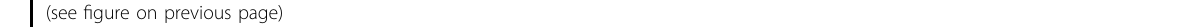
Fig. 4 LSD1 directly interacts with ACE2. a Representative image of uninfected or SARS-CoV-2-infected Caco-2 cells using the Andor WD Revolution Inverted Spinning Disk microscopy system. Cells were permeabilized (intracellular) for immunostaining for ACE2, LSD1, and SARS-CoV-2 N (nucleocapsid). DAPI (blue) was used to visualize nuclei. Scale bar, 12 μ m (inset). The ratio of nuclear to cytoplasmic staining (Fn/c) was also calculated for LSD1 and ACE2: >1 indicates nuclear bias, whereas <1 indicates cytoplasmic bias. The PCC was calculated to assess colocalization in Caco-2 cells with/without infection in the cytoplasmic or nuclear compartments ( n = 20 cells analyzed). Data are mean ± SEM. Mann – Whitney test: ∗∗∗ P < 0.001, ∗∗∗∗ P < 0.0001 denote signi fi cant differences. b Representative image of uninfected or SARS-CoV-2-infected Caco-2 cells using the Andor WD Revolution Inverted Spinning Disk microscopy system. Cells were permeabilized (intracellular) for immunostaining for ACE2, RNA Pol-II, and SARS- CoV-2 N (nucleocapsid). DAPI (blue) was used to visualize nuclei. Scale bar, 12 μ m (inset). Dot plot quanti fi cation of the fl uorescence intensity of ACE2 and RNA Pol-II in uninfected or SARS-CoV-2-infected Caco-2 cells. >50 cells were analyzed for each group. The PCC was calculated for colocalization ( n = 20 cells were analyzed). Mann – Whitney test: ∗ P < 0.05, ∗∗∗∗ P < 0.0001 denote signi fi cant differences. c Representative conservation of the ACE2 c- terminal sequence across multiple species. An NLS (red box) is identi fi ed with three lysines highly likely to be subject to acetylation/demethylation (red). This region may be involved in protein stabilization as there is also a nearby lysine (in orange) highly likely to be ubiquitinated for proteasomal degradation. d ACE2me2 peptide substrate demethylation by LSD1. LSD1 activity was measured by demethylation assay with ACE2me2 peptide of PEP1, PEP2, PEP3, or PEP4. Fluorescent was measured at 40 s intervals on a Synergy H4 multi-mode plate reader. The background rate of ACE2me2 peptide was subtracted in corresponding samples. Statistical signi fi cance was calculated using one-way ANOVA, ∗∗∗∗ P < 0.0001 denote signi fi cant differences. e The C-terminal, cytoplasmic domain of ACE2 contains a putative NLS. This region was unresolved in the recently determined structure (PDB 6M17). Shown is a cartoon representation of the ACE2 structure and the sequence of the unresolved C-terminal domain of ACE2. Underlined residues represent the putative NLS. f Crystals of importin- α bound to FITC-Ahx tagged ACE2 used in diffraction and structure determination. g Structure of importin- α bound to ACE2. Importin- α , shown in cartoon mode (green), bound to ACE2, shown in stick mode (red). Interacting residues are schematically presented with the same color scheme as above. Zoom inset shows that Lys770 forms a critical interaction with the P2 site of importin- α , and methylation of this site would form steric clashes. h Microscale thermophoresis (left) and fl uorescence polarization (right) was used to assess the strength of binding between importin- α and ACE2. Each experiment was carried out with an n = 3, with the KD shown representing the mean and standard deviation. i The electrophoresis mobility shift assay was carried out to con fi rm the interaction between IMP α and ACE2 via the C- terminal domain. ACE2 C-terminal domain is FITC labeled. Left panel is Coomassie stained, right panel is visualized by UV. j Depicts 3D model of ACE2 interaction with importin- α via the NLS in the C-terminal region at Lysine 769, 770, and 771. This model demonstrates that methylation of these lysines would cause steric hindrance and prevent interaction, indicating that ACE2 methylation and non-methylation are important for the importin- α